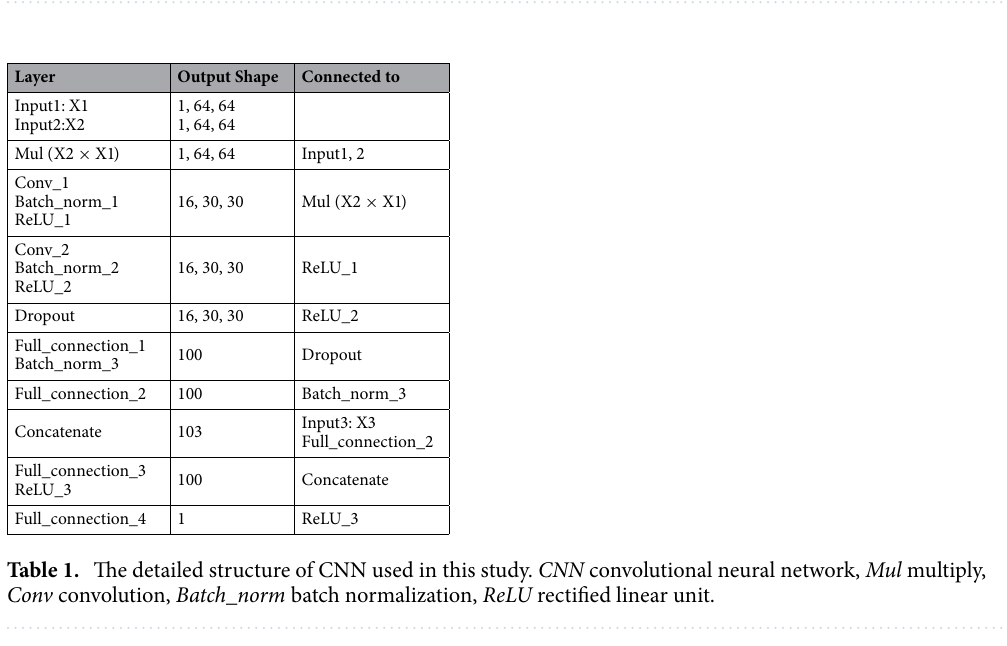
Figure 1. A pipeline of modeling procedure and model evaluation. T training, V validation, CNN convolutional neural network, MHD mean heart dose.